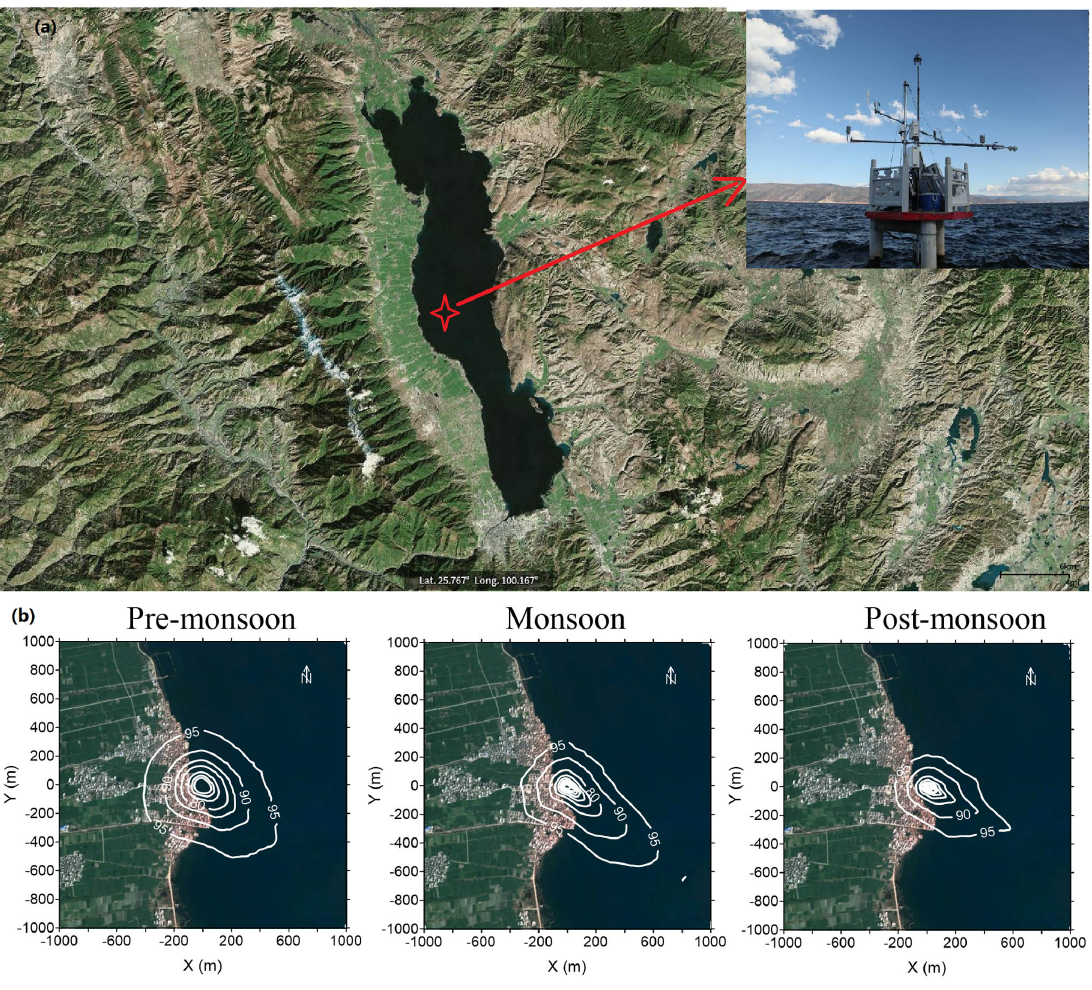
Figure 1. (a) The location of Erhai Lake (Google) and the eddy covariance measurement system (the red star denotes the flux tower); (b) Average footprint source over Erhai Lake flux tower during the three different monsoon periods (pre-monsoon period, monsoon period and post-monsoon period) from 2012 to 2015. The maximum radius of contour lines shows the source area contributing to 95% of